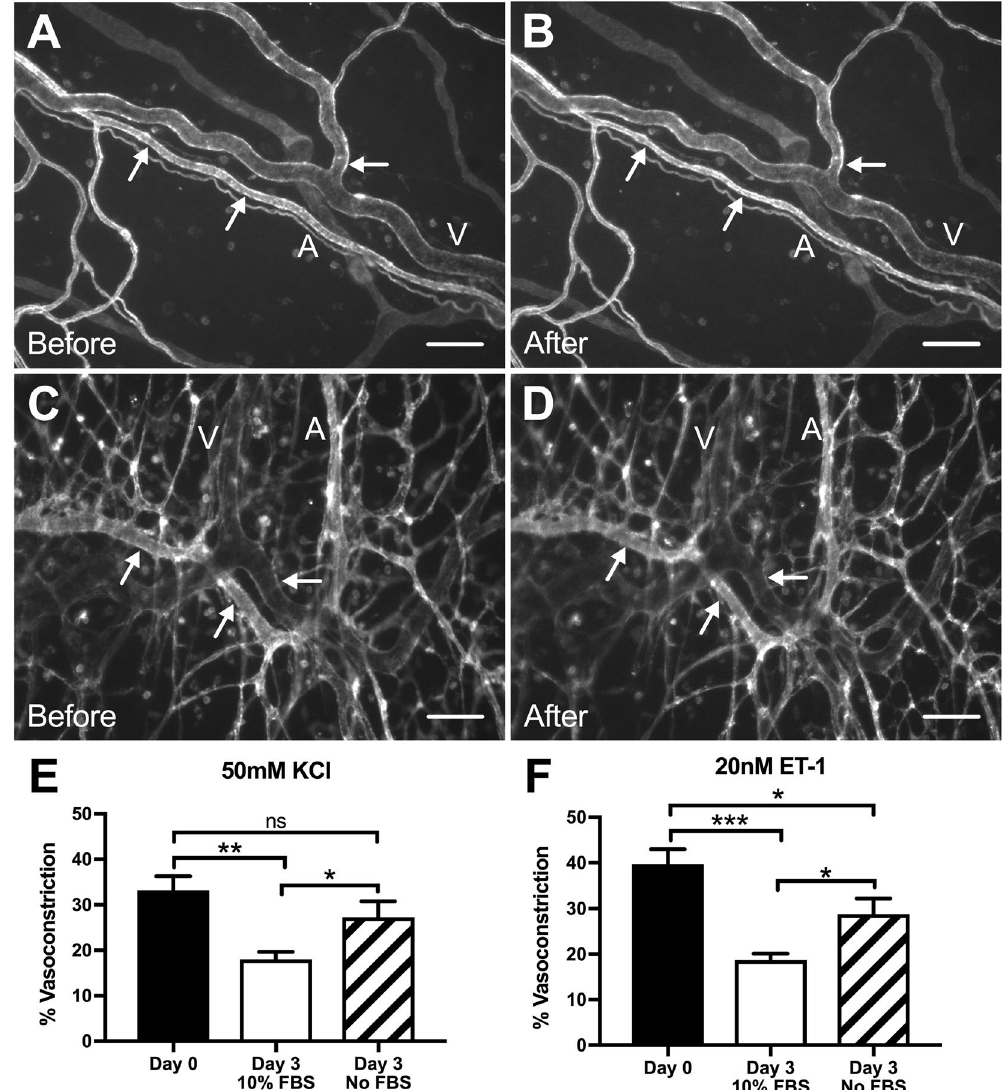
Figure 1. Comparison of arteriole vasoconstriction responses to 50 mM KCl and 20 nM ET-1 between Day 0 (pre-culture) and Day 3 (cultured) ex vivo tissues. ( A–D ) Comparison between Day 0 ( A , B ) and Day 3 + 10% FBS ( C , D ) groups before and after drug exposure demonstrates arteriole constriction in rat mesenteric tissues. Microvascular networks were visualized with BSI-lectin labeling. Arrows indicate points of constriction along the vessel. Scale bars = 100 μ m. A = arteriole, V = venule. ( E , F ) Percent vasoconstriction was quantified after five-minute exposure to 50 mM KCl and 20 nM ET-1, respectively. Black, white, and striped bars represent Day 0, Day 3 + 10% FBS, and Day 3 + No FBS groups respectively. * , ** , and *** indicates a significant difference of p < 0.05, p < 0.01, and p < 0.001 respectively by One-Way ANOVA and Student-Newman-Keuls post hoc method. “ns” Indicates no significant difference (p >